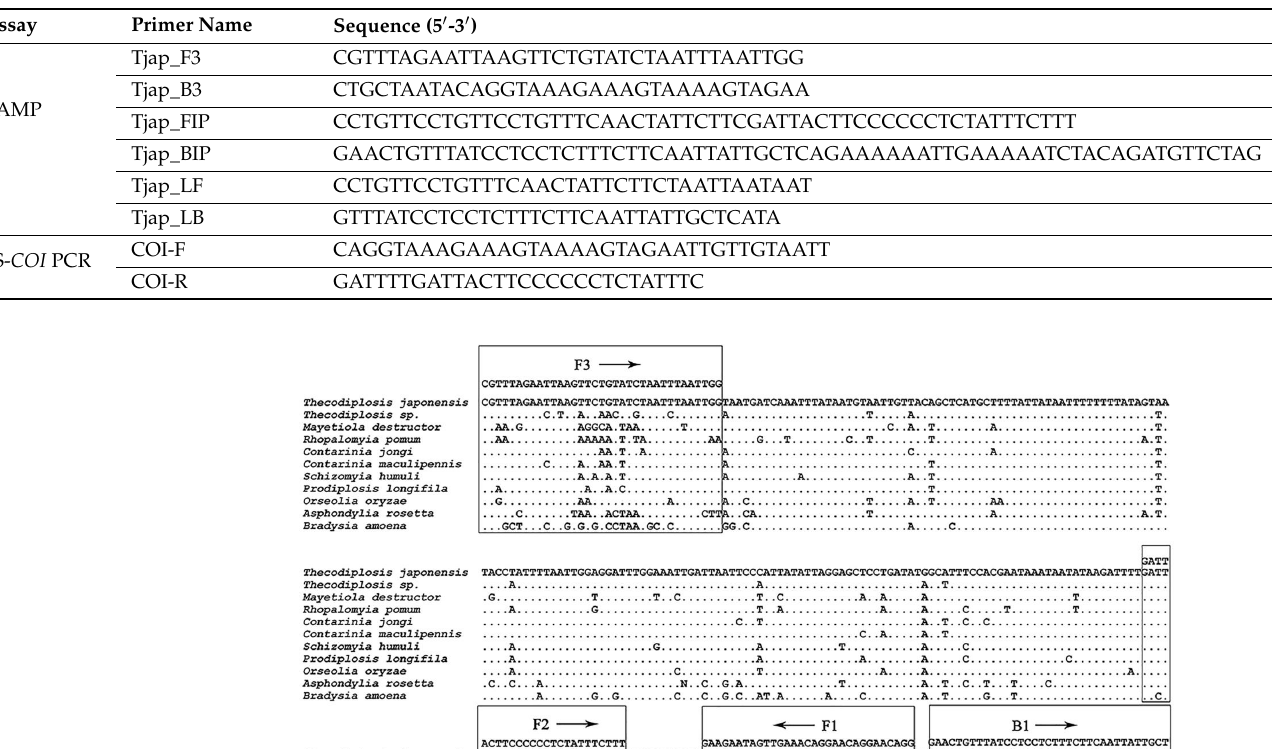
Table 2. Primers for LAMP and SS- COI PCR.